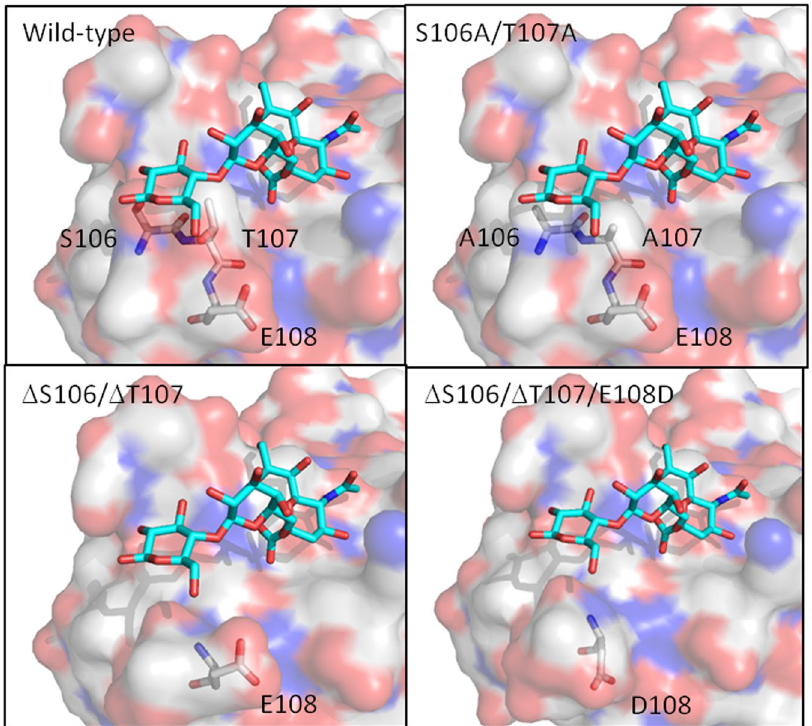
Figure 2. Surface representation of the wild-type and SubB mutants modeled with Neu5GC α 2–6Gal β 1–3Glc (shown as a cyan stick). The mutated SubB residues are shown as grey sticks and red and blue residues represent oxygen and nitrogen,